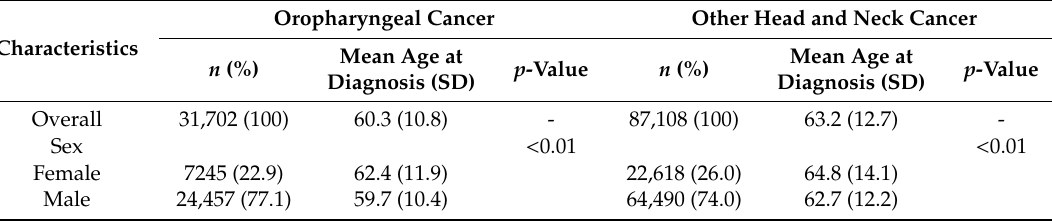
Table 1. Characteristics of head and neck cancer (HNC) patients, Surveillance, Epidemiology, and End Results (SEER) 9,